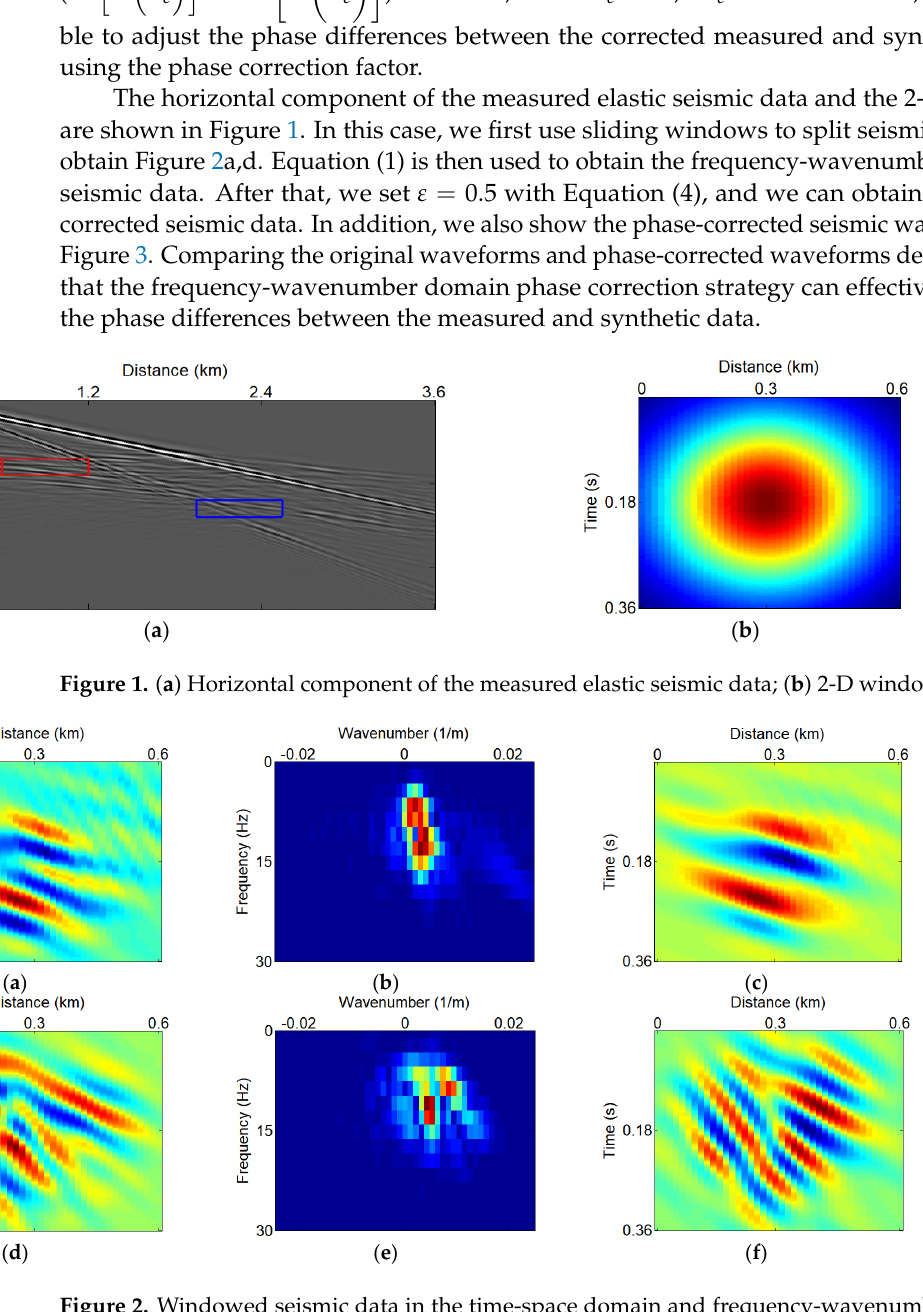
( a ) ( b ) Figure 3. Seismic waveforms. ( a ) Measured and synthetic data; ( b ) phase - corrected measured and synthetic data.